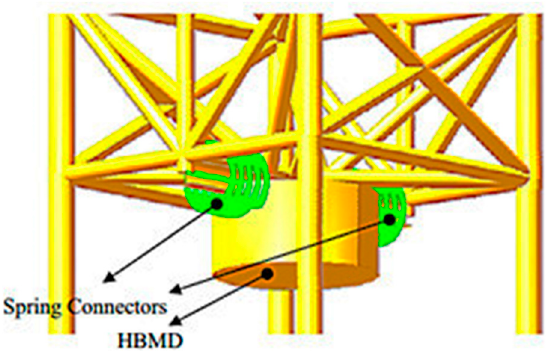
Figure 2. Schematic of the hydrodynamic buoyant mass damper (HBMD) [17].